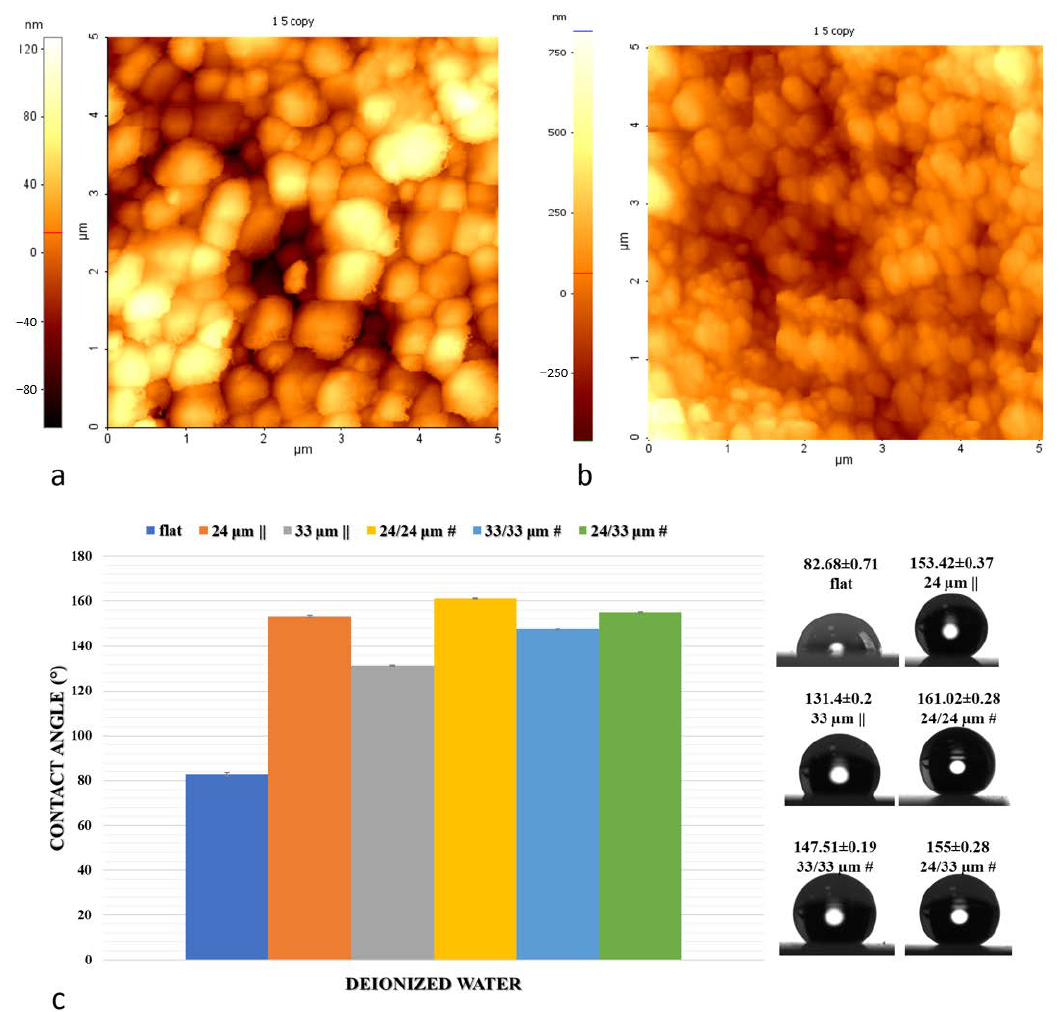
Figure 3. Atomic force microscopy AFM images of typical surfaces of the samples before ( a ) and after irradiation ( b ). ( c ) Contact angle